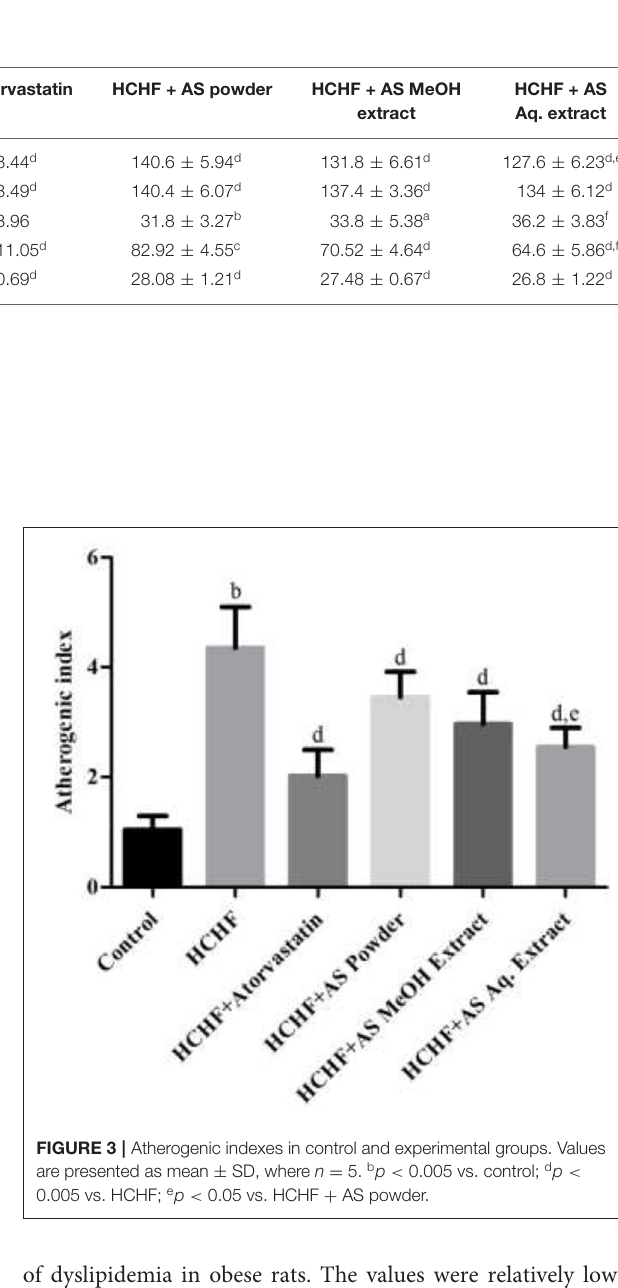
extract Aq. extract